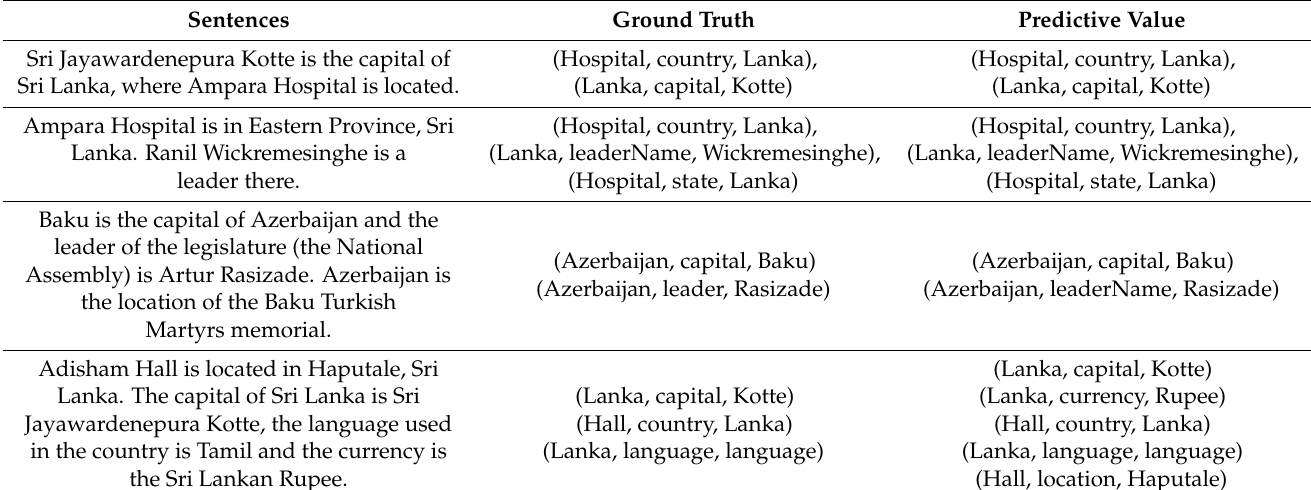
Table 9. Case study for